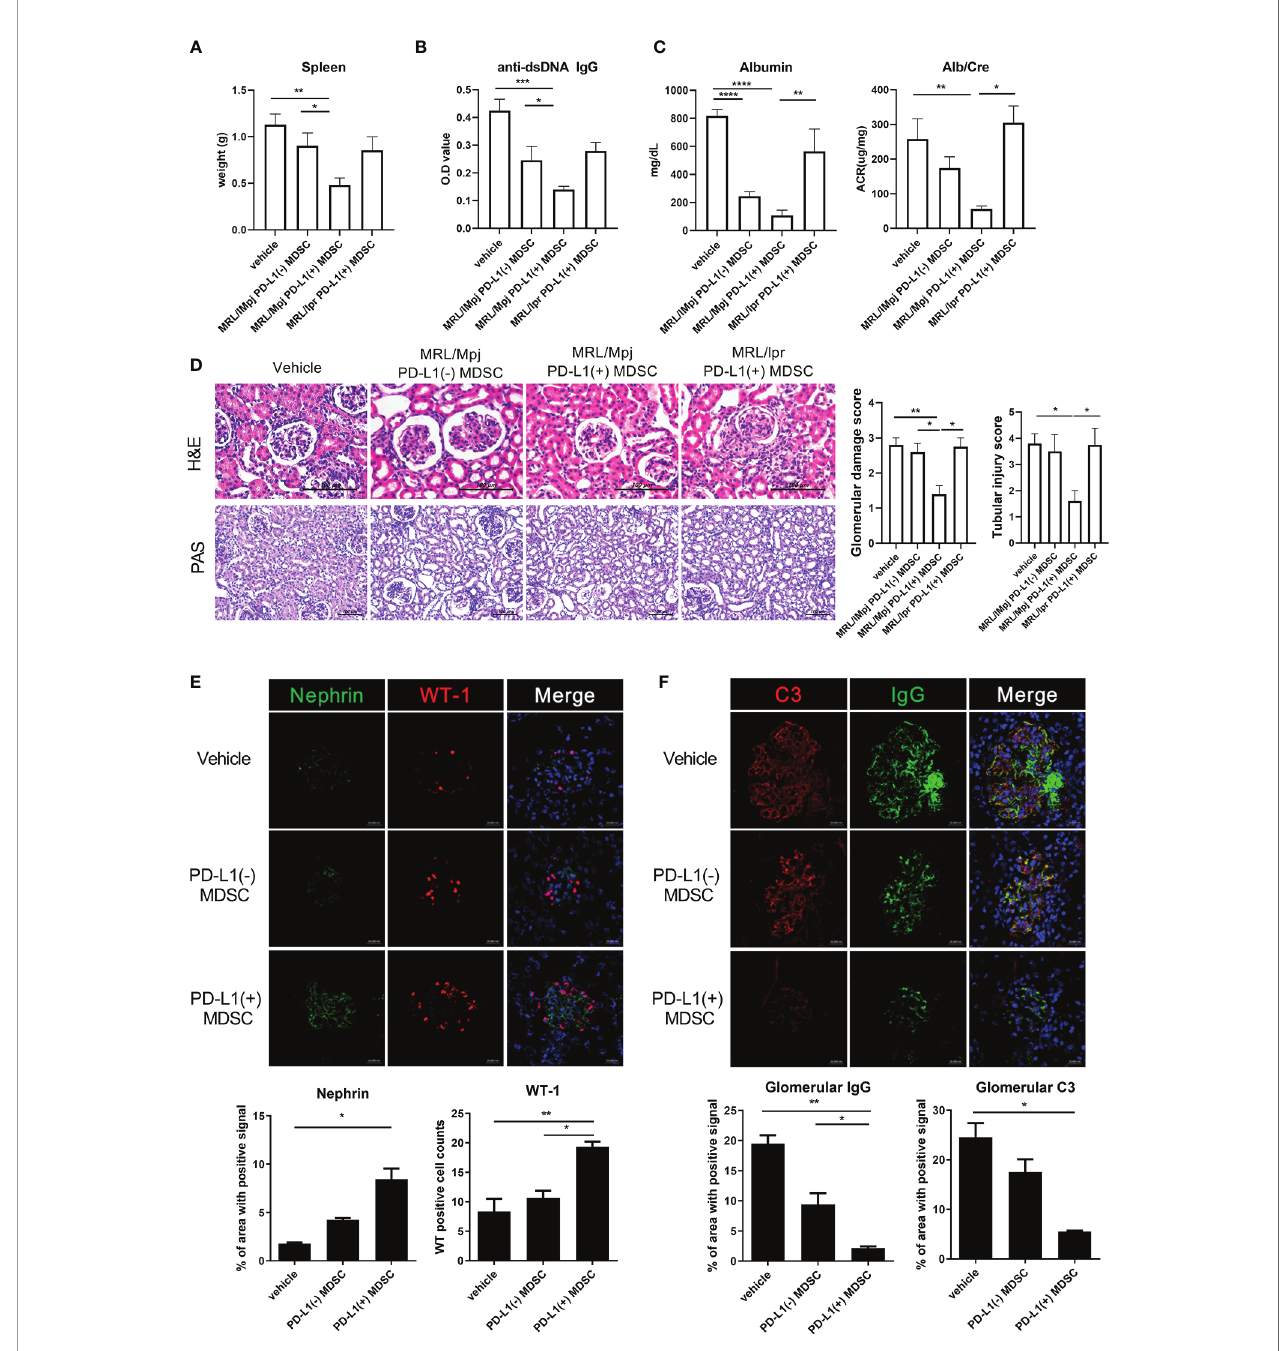
FIGURE 4 | In vivo treatment with PD-L1 positive MDSCs shows better therapeutic effects in MRL/ lpr mice. (A) Ten-week-old MRL/ lpr mice (n=10 in each group) were treated intravenously with 1 × 10 6 PD-L1 positive and/or negative MDSCs from MRL/MpJ mice or 1 × 10 6 PD-L1 positive MDSCs from MRL/ lpr mice once weekly for six weeks. One week after the last treatment, mice were sacri fi ced. Spleen weights are shown. (B) Serum levels of anti-dsDNA IgG were determined by ELISA. (C) Urinary albumin and Creatinine (Cr) levels were measured and Albumin/Cr ratio is shown. (D) Representative images of H&E and PAS staining of the kidney sections are shown in the left panel. Tubular injury and glomerular damage score is shown. (E) Representative confocal microscopic images of kidney sections are shown. Cells were stained with fl uorescence-tagged antibodies to identify podocyte markers including nephrin (green) and Wilms tumor protein (WT-1) (red). Nephrin signal positive area were calculated using image J software and the mean values are presented. The cells showing positive WT-1 signal were enumerated and the mean values are presented. (F) Cells were stained with antibodies to identify C3 (red) and IgG (green). IgG and/or C3 signal positive area were calculated and the mean values are presented. Data are expressed as the mean ± SEM. Data are representative of 2 independent experiments [*p<0.05, **p<0.01, ***p<0.001, ****p<0.0001 versus control